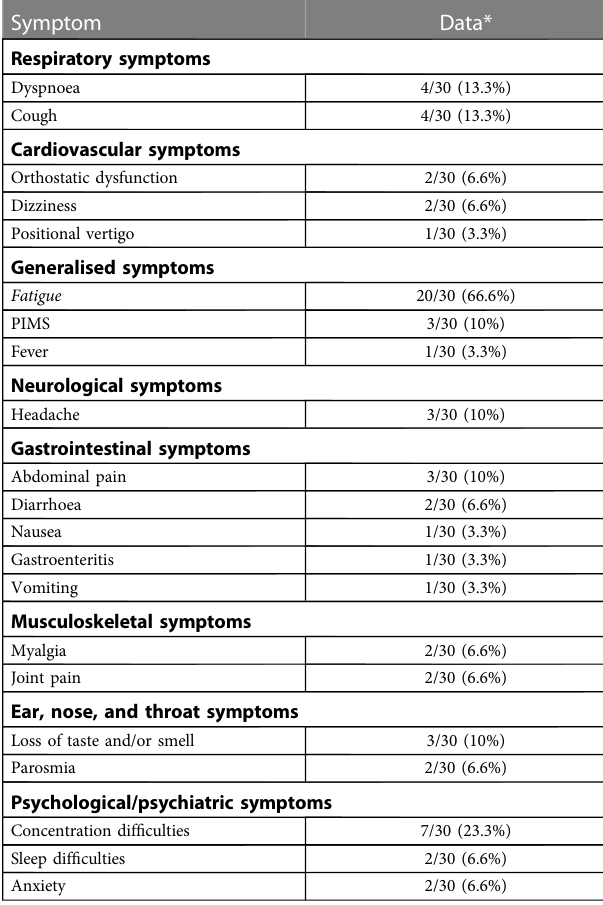
TABLE 2 Description of symptoms in the long COVID group.